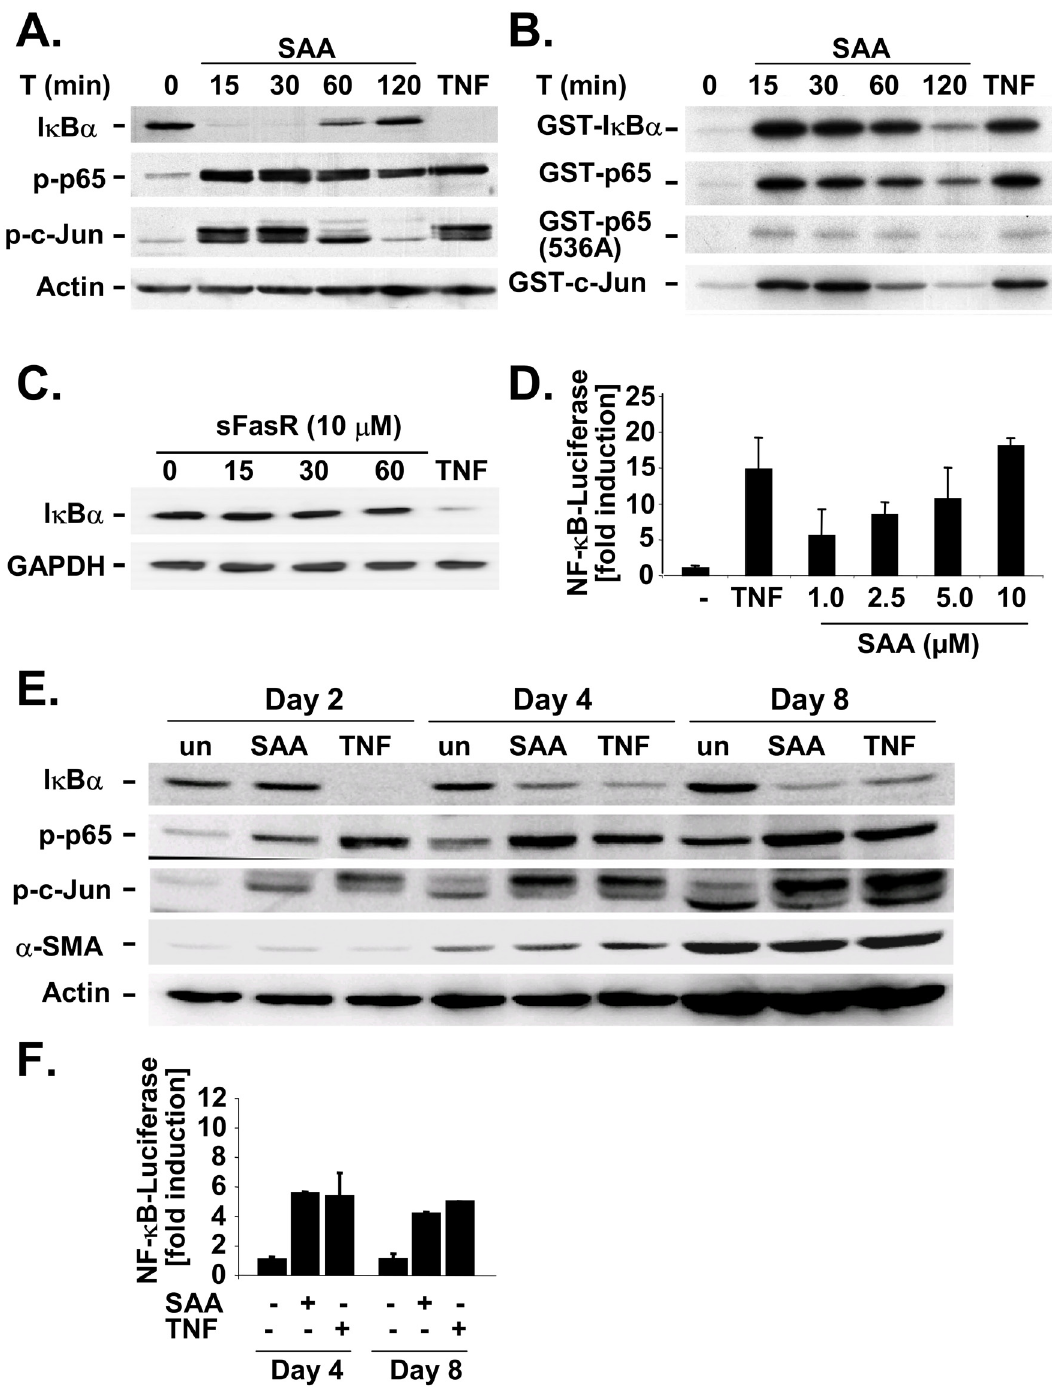
Fig 1. SAA induces IKK and JNK activation in HSCs. A-B. Activated human HSCs were treated with recombinant human SAA (5 μ M) for the indicated times or with rhTNF α for 15 minutes. Extracts were subjected to western blot analysis using antibodies that recognize I κ B α , phospho-p65 (S536), phospho-c- Jun or actin ( A ). Results were confirmed by in vitro kinase assay using GST-I κ B α , GST-p65, GST-p65 (S536A) and GST-c-Jun substrates ( B ). C. Activated human HSCs were treated with recombinant human sFasR (10 μ M) for the indicated times or with rhTNF α for 15 minutes. Extracts were analyzed by western blot using antibodies against I κ B α or GAPDH. D. Activated human HSCs were infected with adenoviruses expressing NF- κ B driven luciferase followed by treated with the indicated concentrations of SAA or with rhTNF α (10 ng/ml) for 6h. Lucerifase activity is expressed as fold induction in comparison to untreated control. E. Primary rat HSCs were activated for 2, 4 and 8 days and treated with SAA (5 μ M) or rmTNF α (30 ng/ml) for 15 minutes. Extracts were subjected to western blot analysis using antibodies that recognize I κ B α , phospho-p65 (S536), phospho-c-Jun or actin. F. Primary rat HSCs were activated for